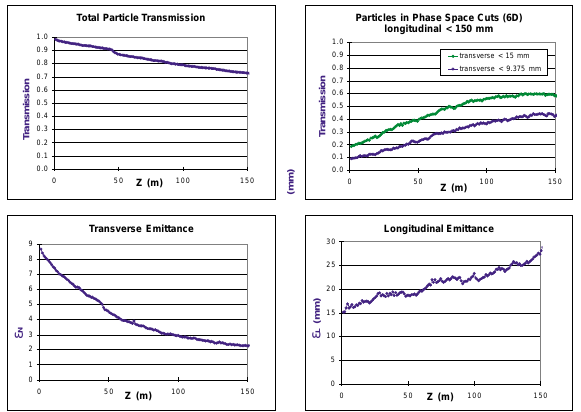
FIG. 6. (Color) FOFO channel performance as a function of the longitudinal coordinate z . Top right: fractional transmission; top left: transmission into the acceleration acceptance cuts, upper curve (blue line) with a 9.375 mm rad transverse cut, lower curve (green line) with a 15 mm rad transverse cut; bottom left: transverse emittance; bottom right: longitudinal emittance.